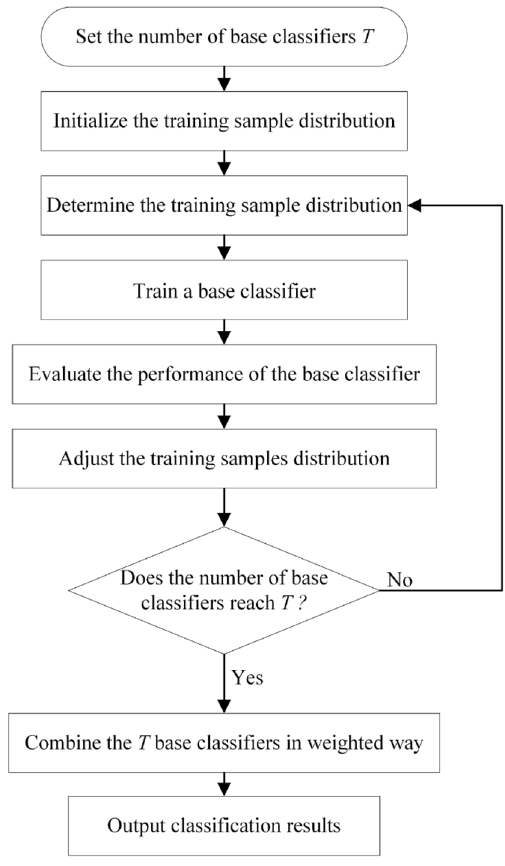
Figure 2. The steps to construct the boosting